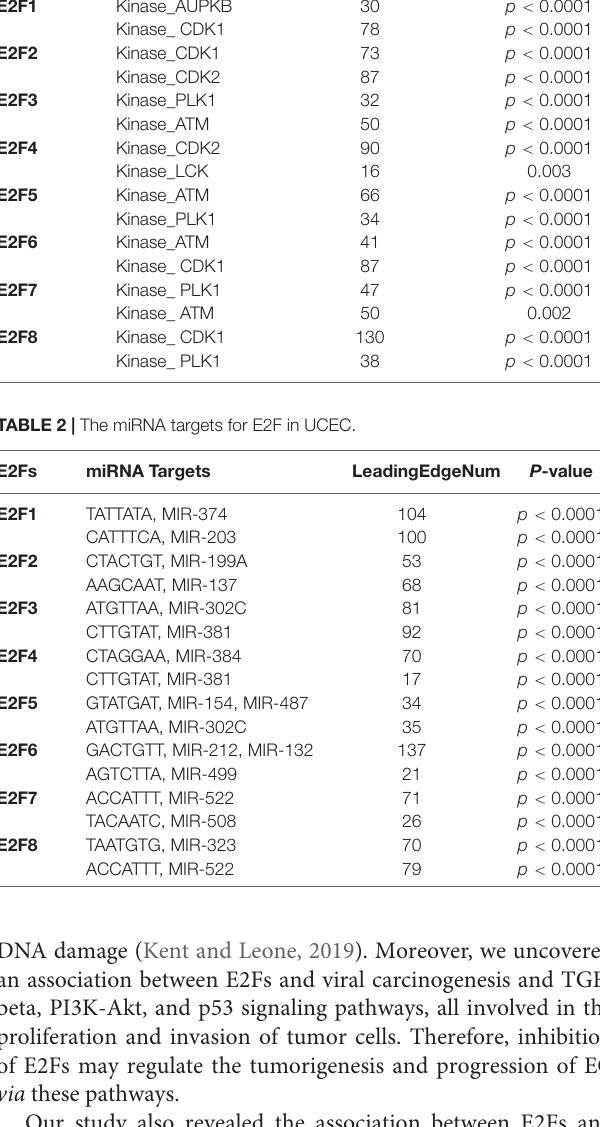
TABLE 1 | The Kinase targets for E2Fs in UCEC. E2Fs Kinase Targets